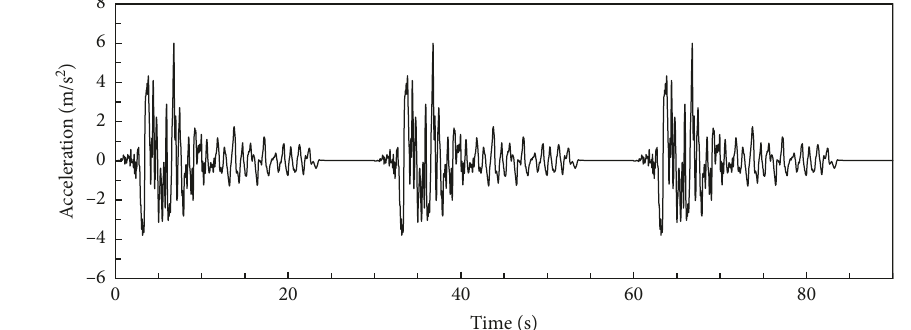
Figure 4: Seismic ground motion of Northridge.